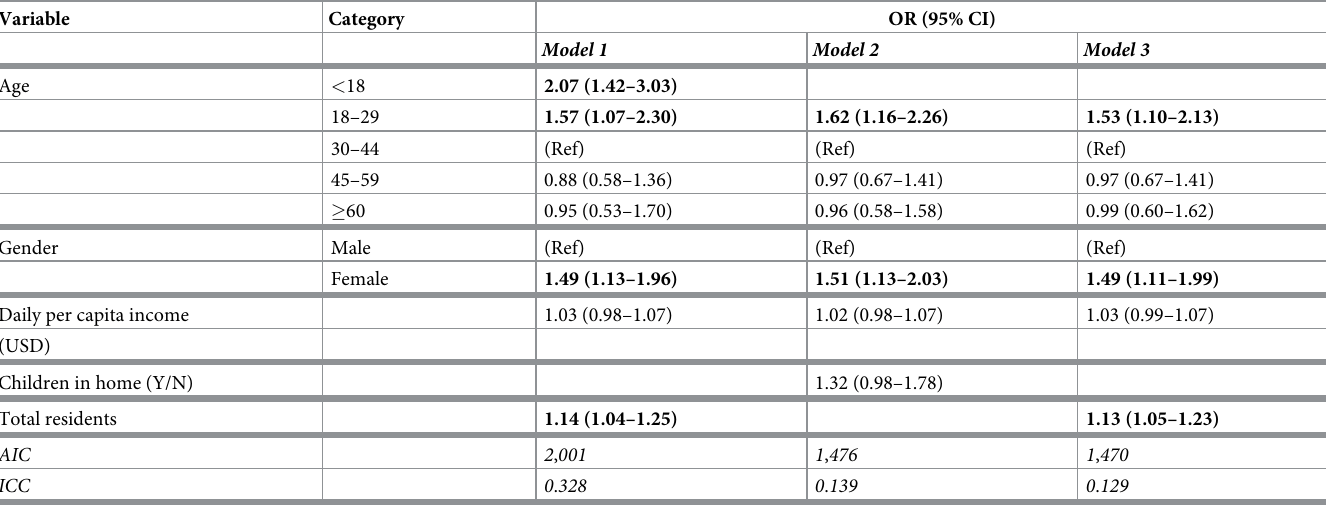
Table 2. Effect (odds ratio) of age and presence of children in the household.